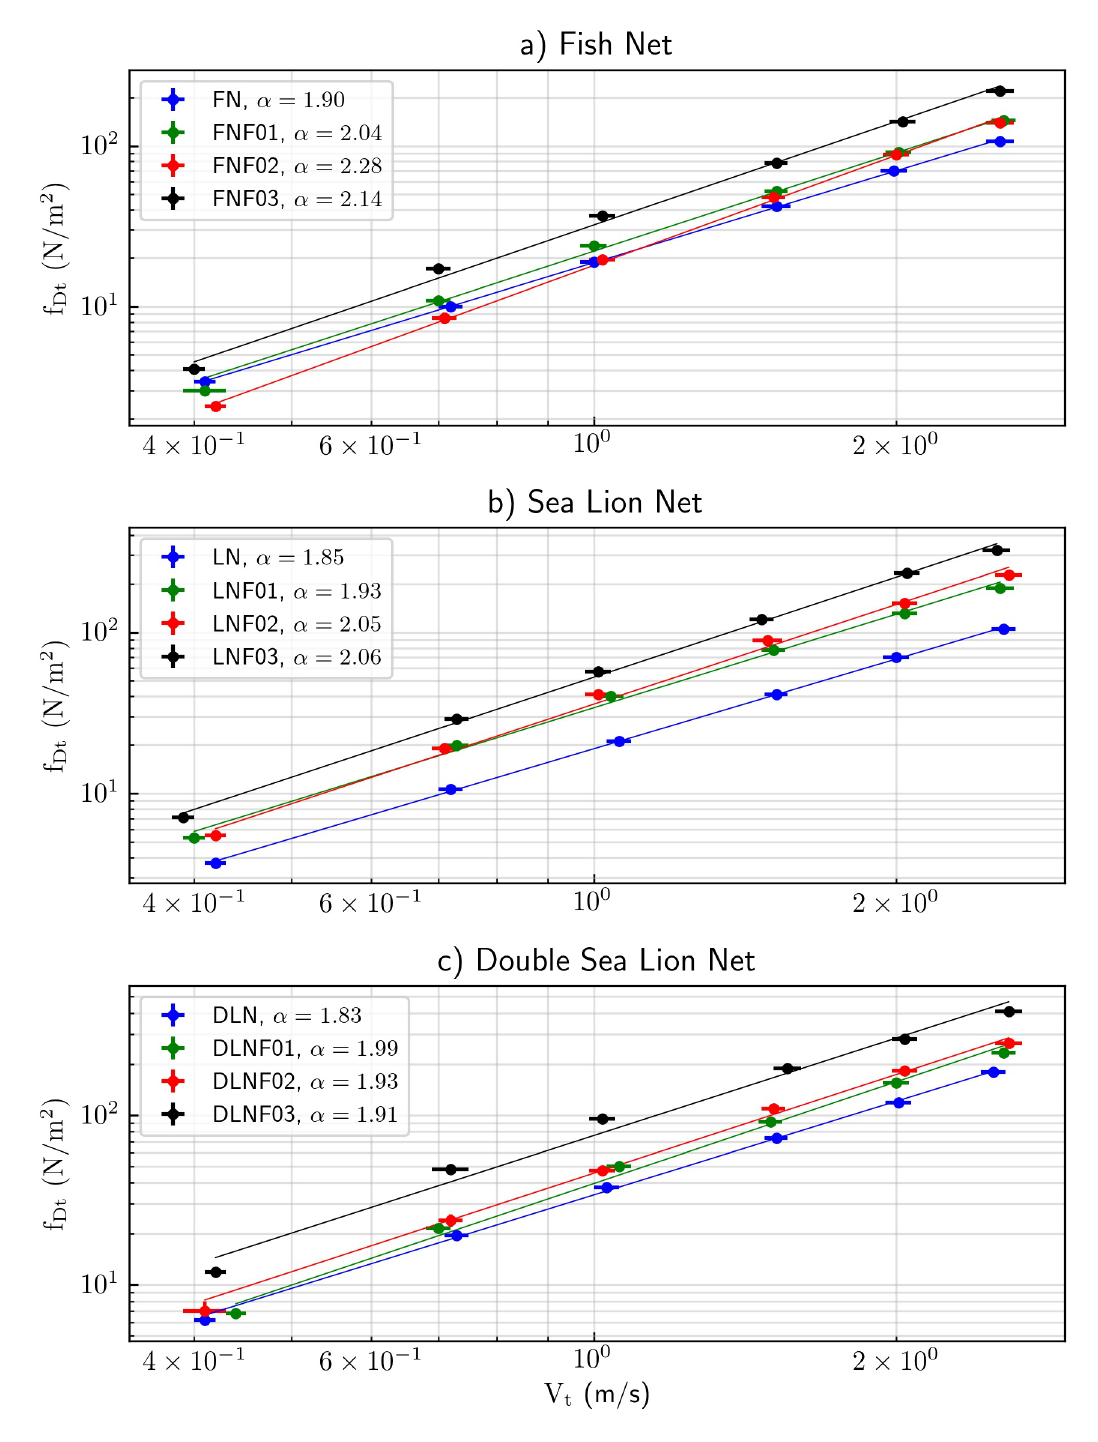
Figure 6. Experimental results of tangential drag force for fish and sea lion nets versus Reynolds number. Experimental series, clean or without fouling, from Table 1. Lines represent a power law fit of the